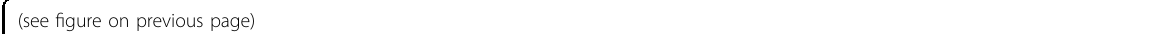
Fig. 3 SET8 overexpression reversed high glucose-mediated endothelial in fl ammation. a Results from the western blot analysis of SET8 and H4K20me1 in HUVECs, HUVEC nuclei, and HUVEC cytoplasm cultured under normal or high-glucose conditions. b qPCR analysis of SET8 in HUVECs cultured under normal or high-glucose conditions. c Results from the western blot analysis of SET8, PTEN, p-p65, e-selectin, and ICAM-1 expressions in HUVECs overexpressing SET8 under high-glucose conditions. d qPCR analysis of SET8, PTEN, p-p65, e-selectin, and ICAM-1 expressions in HUVECs overexpressing SET8 under high-glucose conditions. e Monocyte/endothelial adhesion under normal or high-glucose conditions and with SET8- overexpressing HUVECs under high-glucose conditions was measured. f Results from the western blot analysis of SET8, PTEN, p-p65, e-selectin, and ICAM-1 expressions in HUVECs expressing shSET8. g Results from the qPCR analysis of SET8, PTEN, p-p65, e-selectin, and ICAM-1 expressions in HUVECs expressing shSET8. h Monocyte/endothelial adhesion under normal conditions and in the presence of HUVECs expressing shSET8 was measured. i The results from the western blot analysis of SET8, PTEN, p-p65, e-selectin, and ICAM-1 expressions in HUVECs in which SET8 was silenced and PTEN was downregulated. j Results from the qPCR analysis of SET8, PTEN, e-selectin, and ICAM-1 expressions in HUVECs in which SET8 was silenced and PTEN was downregulated. k Monocyte/endothelial adhesion in the presence of HUVECs expressing shSET8 or shSET8 + siPTEN was measured. * P < 0.05, compared with the control group; # P < 0.05, compared with the high-glucose treatment or shSET8 treatment group, n =